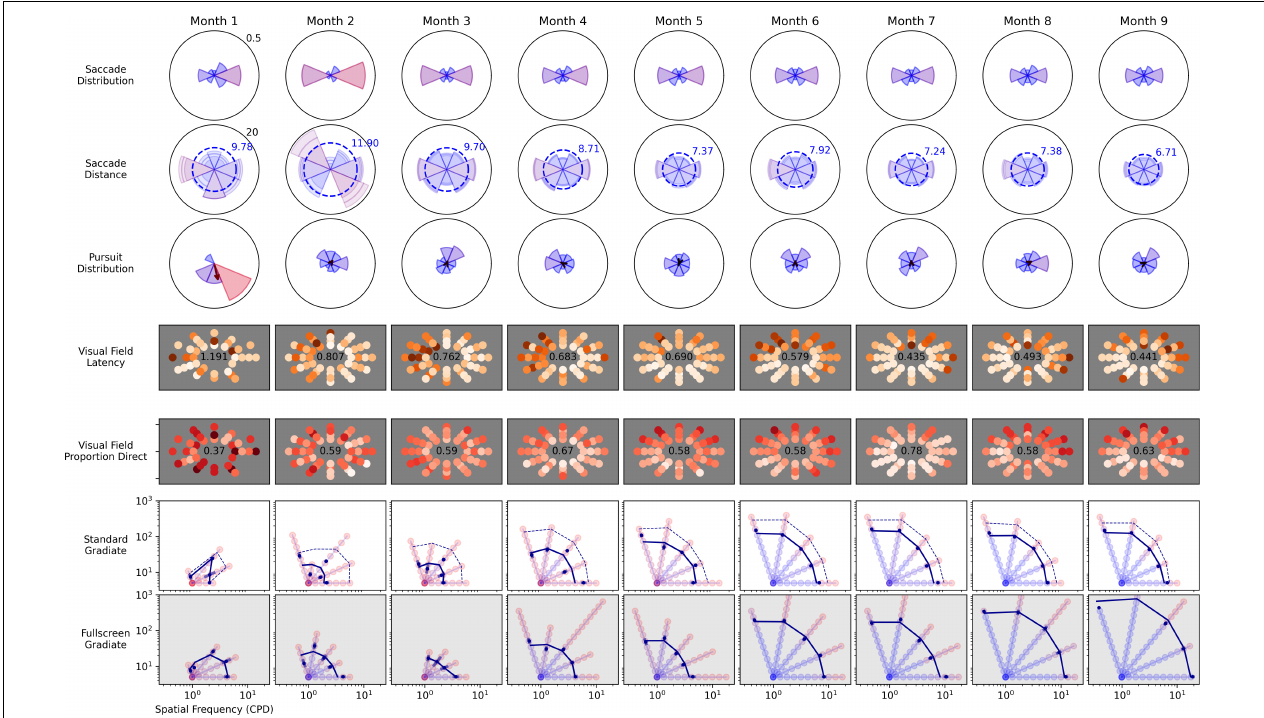
FIGURE 10 | Longitudinal recovery from a traumatic brain injury for observer C5 over 9 months. The child was admitted to Blythedale Children’s Hospital approximately 3 months after accident and immediately enrolled in the study. He was non-communicative for approximately 2 months post enrollment. All plot layouts, axes, and units are identical to their corresponding previous